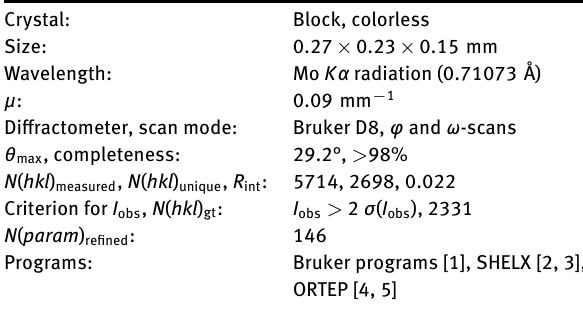
Table 1: Data collection and handling.